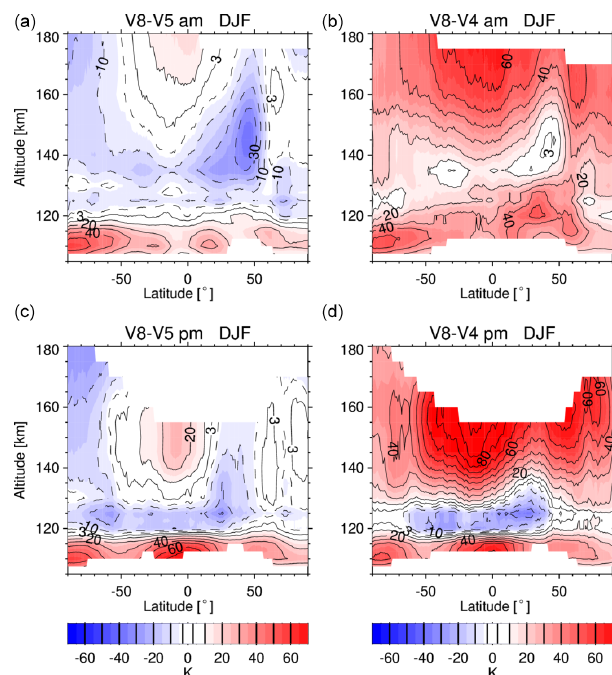
Figure 18. Northern winter (December–February, DJF) composite zonal mean distributions of the temperature differences between UA data version 8 with respect to (a, c) version 5 (V5r_TwNO_622) and (b, d) version 4 (V4r_TwNO_611) as a function of latitude and altitude, separated for morning (a, b) and afternoon (c, d)